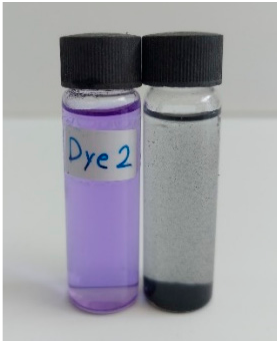
Figure 10. Photograph of Dye 2 solution before and after adsorption onto Fe 3 O 4 -carbon-based com- posite.